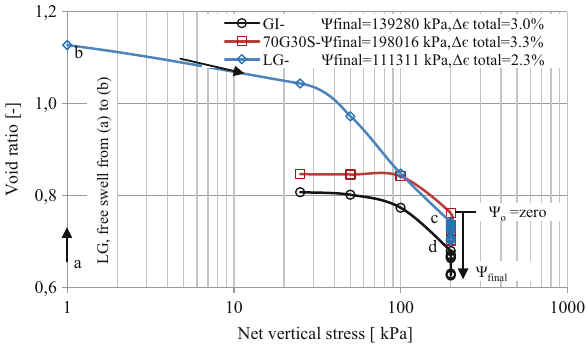
Figure 11: Variation of the void ratio with suction of the ( CN - SI ) drying test.